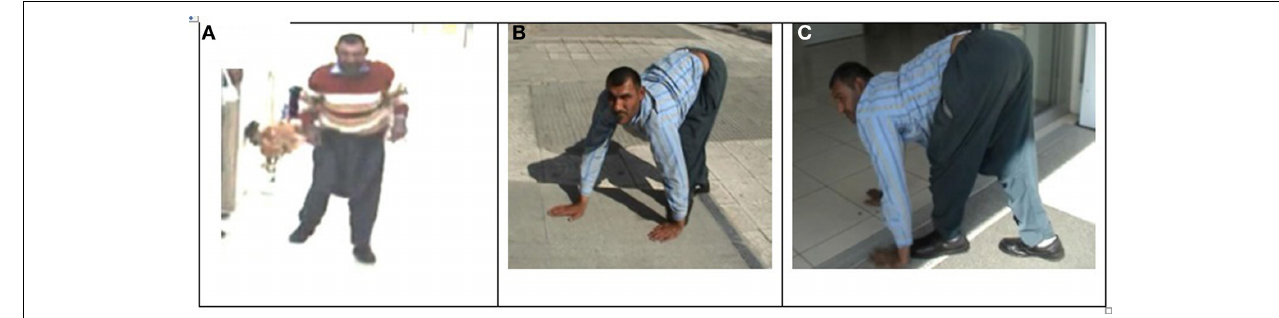
FIGURE 3 | Case IV-16: ataxic upright walking (A), diagonal QL with interference between left hand and left foot (B,C).